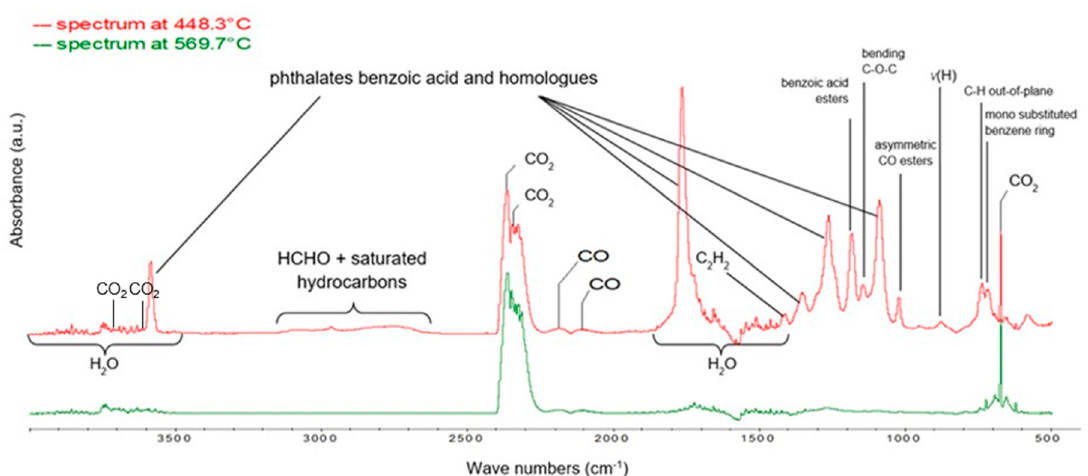
Figure 7. FTIR spectra recorded for pure PET in the range of 500–4000 cm − 1 at temperatures characteristic of the oxidative degradation process: 448.3 and 569.7 °C, respectively, determined on the basis of DTG curves. Qualitative characteristics of the spectrum were obtained using Nicolet™ FTIR Vapor Phase Spectral Library software and [34].